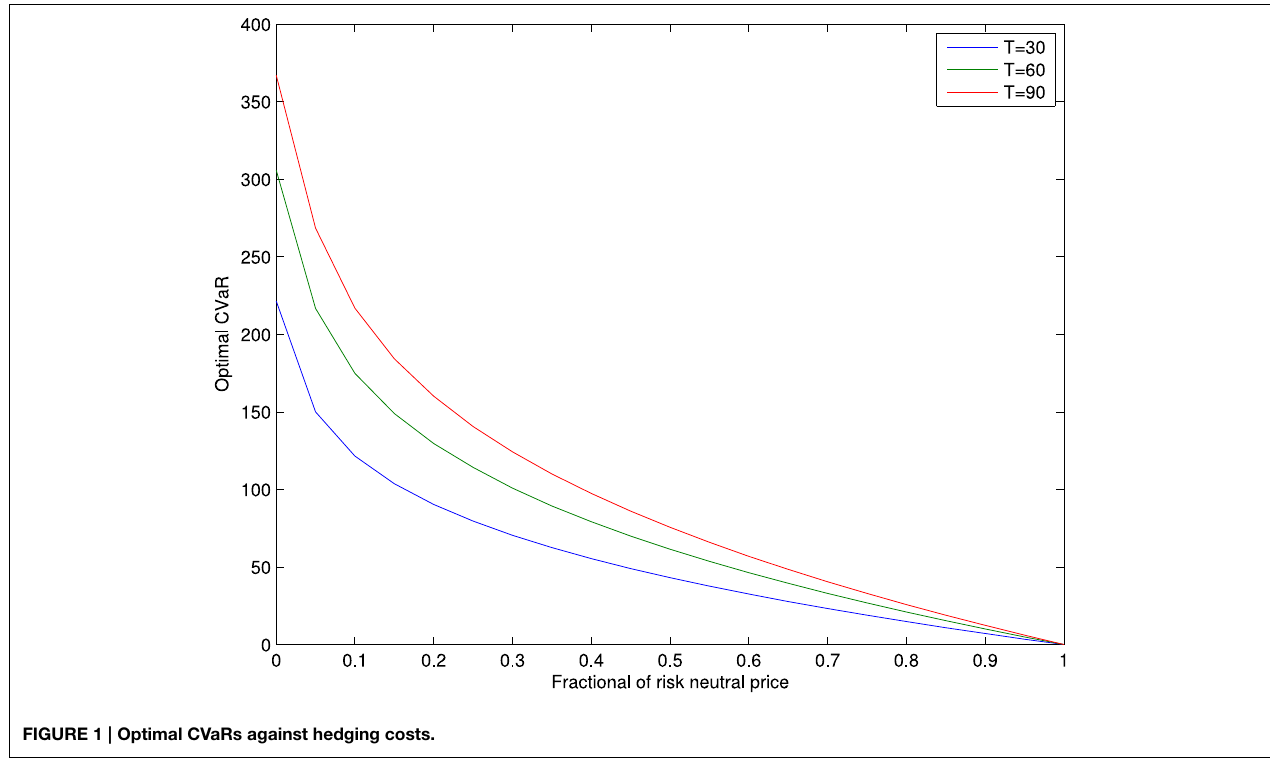
FIGURE 1 | Optimal CVaRs against hedging costs.